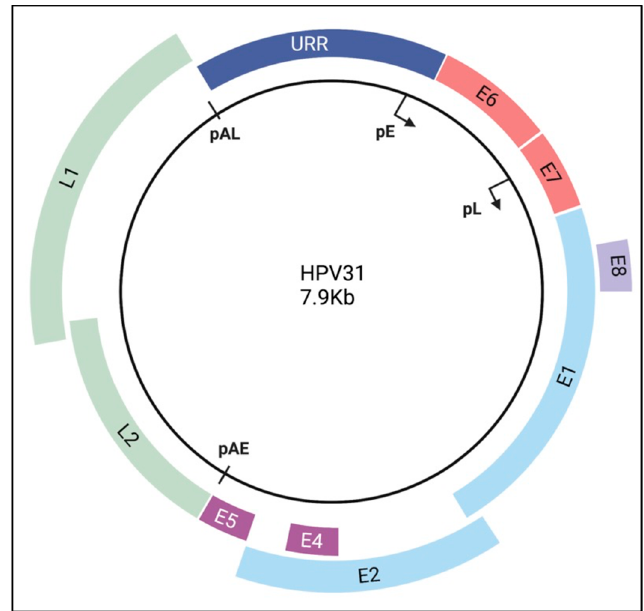
Figure 1. Genomic organization of high-risk HPV31. The open reading frames are designated by the color blocks. The early promoter (pE) is located upstream of the E6 ORF (p97 for HPV16, HPV31; p105 for HPV18), and the late promoter (pL) is located in the E7 ORF (p742 for HPV31, p811 for HPV18, p670 for HPV16). Expression of E8^E2C is driven by a promoter in the E1 ORF (not shown). The early polyadenylation site (pAE) is located at the end of the E5 ORF, and the late polyadenylation site (pAL) is located at the end of the L1 ORF. The upstream regulatory region (URR) is an untranslated region that contains the keratinocyte enhancer, the origin of replication, as well as binding sites for E1 and E2 and various transcription factors. Created with BioRender.com (accessed on 18 January 2022).